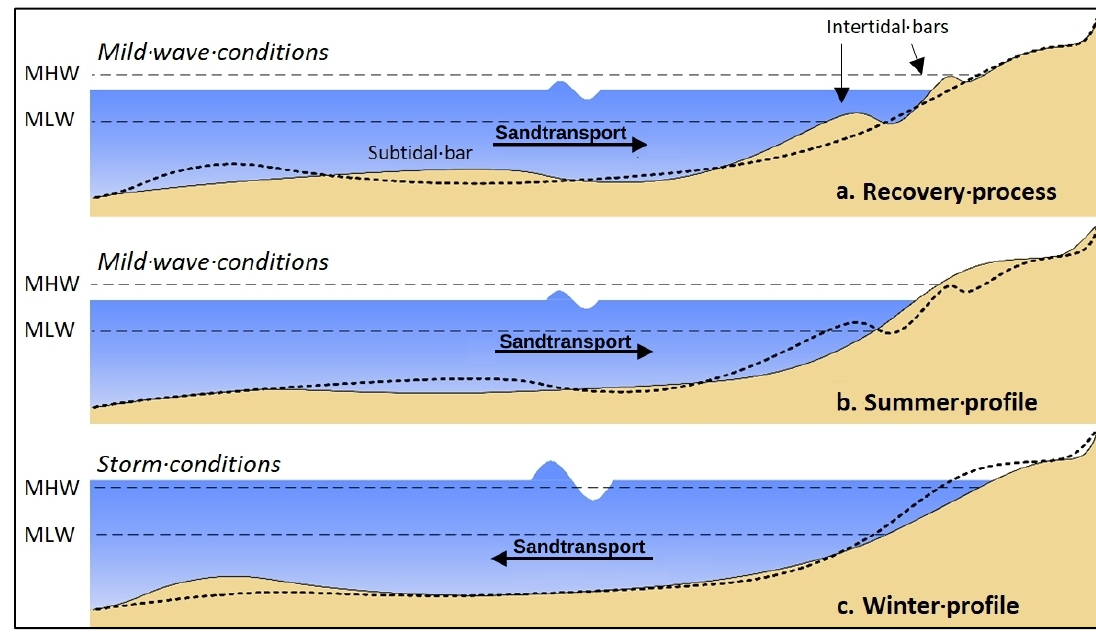
Figure 1 . Cross-shore variability during the recovery phase ( a ) from a winter profile ( c ), to a summer profile ( b ) with the solid line indicating the profile at the described stage and the dotted line indicating the profile at the previous stage. MHW and MLW indicate the mean high and low water, respectively.